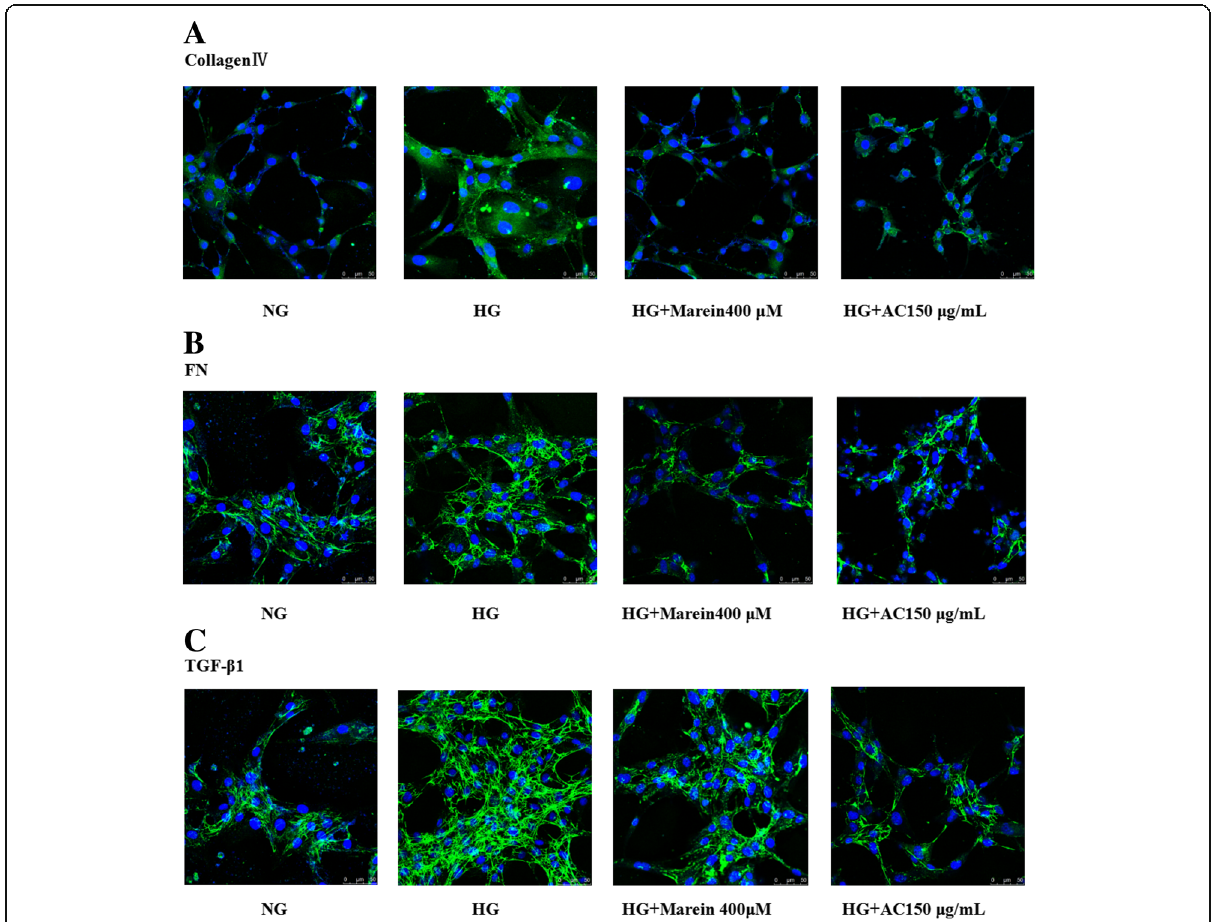
Fig. 3 a Effect of AC and marein on collagen IV distribution in HG-treated HBZY-1 cells observed by immunofluorescence assay. b Effect of AC and marein on FN distribution in HG-treated HBZY-1 cells observed by immunofluorescence assay. c Effect of AC and marein on TGF- β 1 distribution in HG-treated HBZY-1 cells observed by immunofluorescence assay. Note: Values were expressed as the mean ± SD, n = 4. # P < 0.01 versus normal group; * P < 0.05 versus control group; ** P < 0.01 versus control